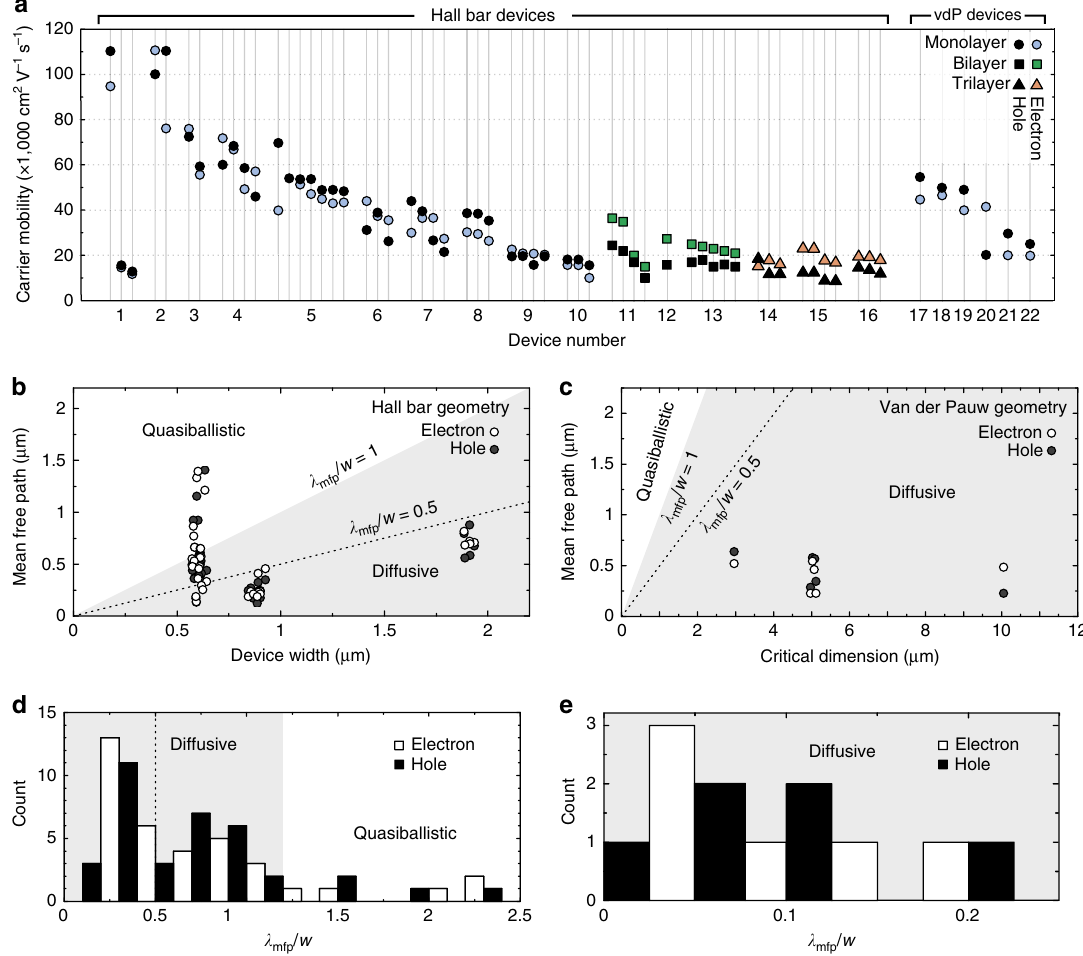
Figure 6 | Mobility and mean-free path statistics. ( a ) Room temperature field effect carrier mobility plot for all the devices (Hall bar and van der Pauw) in this study. ( b ) Plot of electron and hole mobility for all monolayer Hall bar devices. Quasiballistic ( l mfp Z w ) and diffusive ( w 4 l mfp ) regimes are indicated by the white and grey regions, respectively. Note that 60% of our narrow channel devices have a calculated mean-free path larger than w /2 (dashed line), a clear indication of transport affected by boundary scattering 17 . ( c ) Plot of electron and hole mean free path for all monolayer van der Pauw devices. Quasiballistic ( l mfp Z w ) and diffusive ( w 4 l mfp ) regimes are indicated by the grey region. The average mean-free path is 450 ± 170 and 420 ± 140nm for holes and electrons, respectively. ( d ) Histogram of monolayer electron and hole mean free path for all Hall bar devices. ( e ) Histogram of monolayer electron and hole mean free path for all van der Pauw